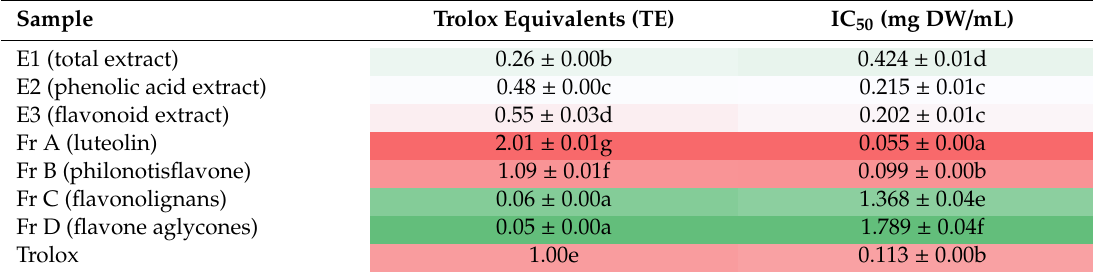
Table 3. Antioxidant activity of extracts (E1–E3) and flavonoid fractions (A–D) of dandelion fruits against DPPH free radical (mean ± SD, n = 3) a,b .